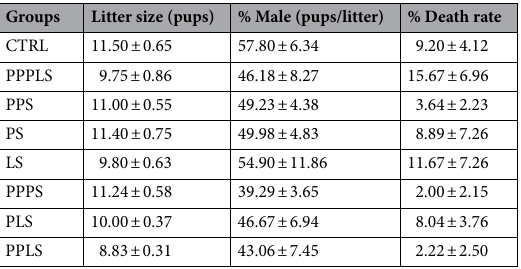
Table 1. Effects of variable stress on litter size, percent males, and death